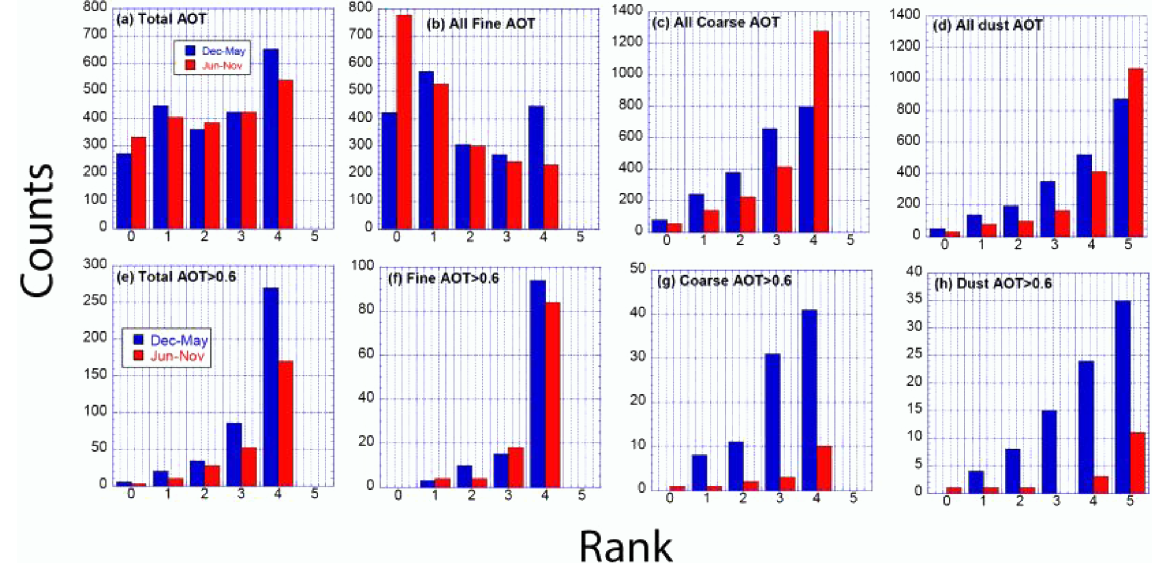
Figure 10. (a) – (d) , bi-seasonal rank histograms of ICAP-MME members and the ensemble mean total, fine, coarse and dust AOT for all data. (e) – (h) same as previous for cases where AERONET